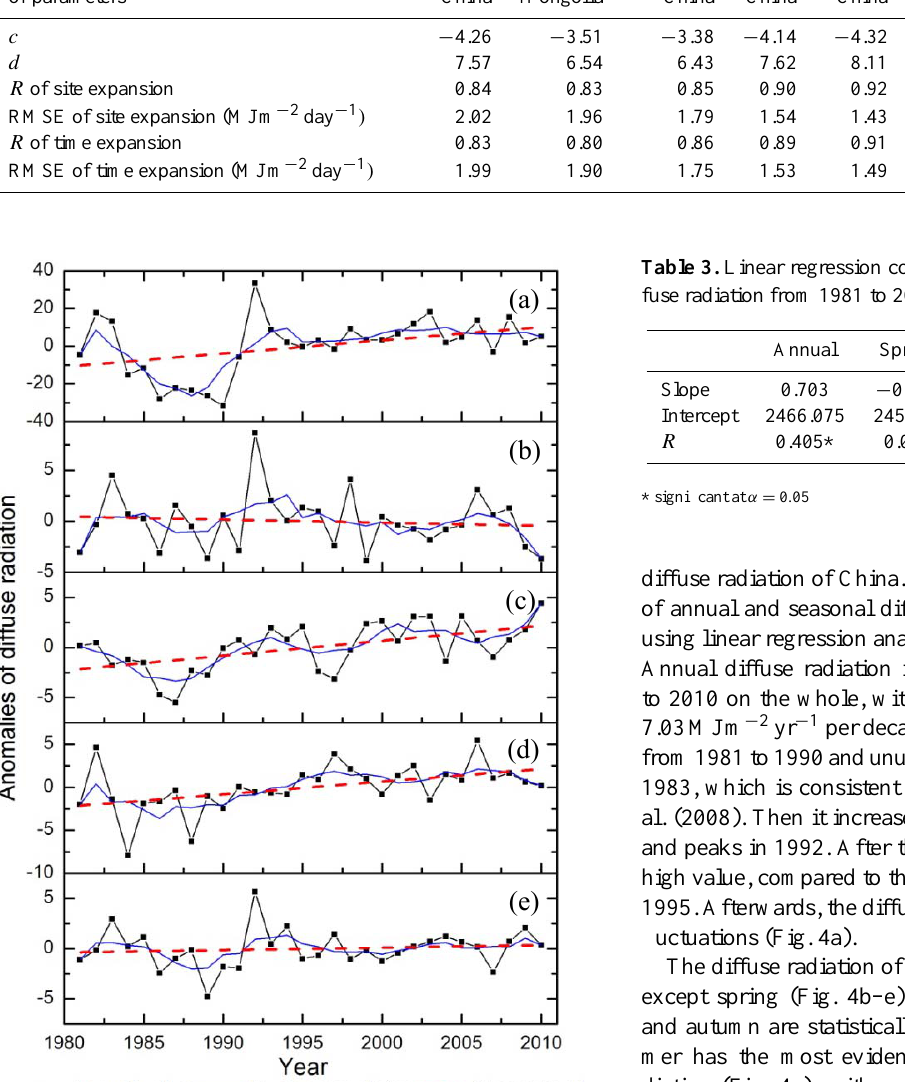
Table 2. Results of the calibration and validation of Boland model in different regions across China. Estimated values and validation of parameters